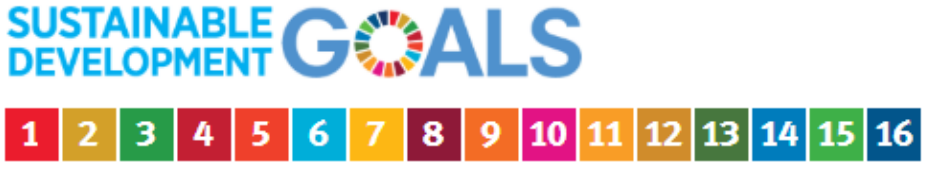
Figure 2: ISO/TC 323 Circular Economy Contribution to UN